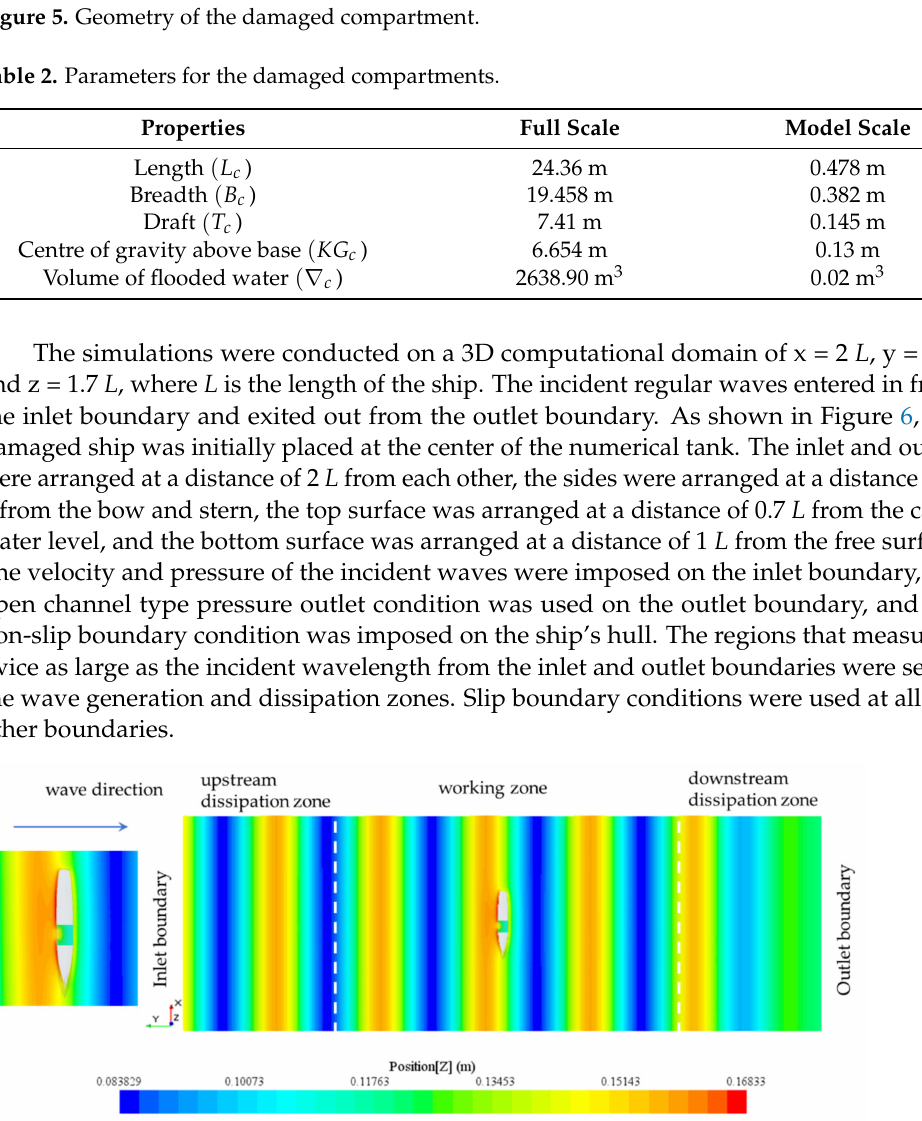
Figure 6. Computational domain for the damaged ship